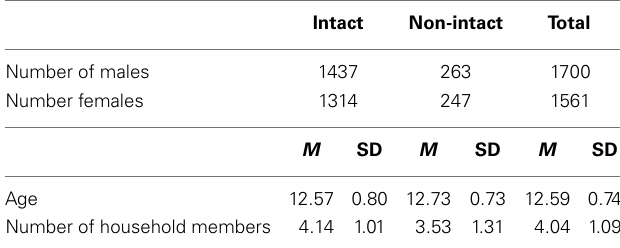
Table 1 | Descriptive statistics of respondents by family